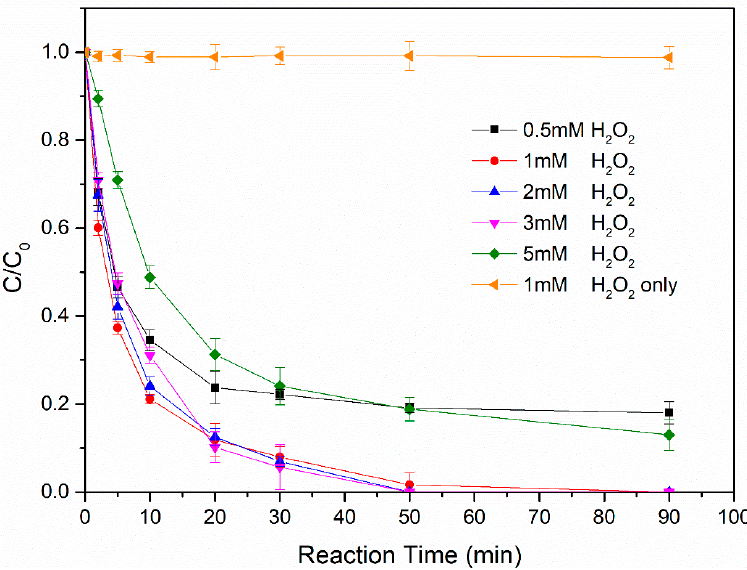
Figure 4. Effect of H 2 O 2 concentration on 2,4-D degradation ([2,4-D] 0 = 5.0 mg/L, [Fe 0 @Fe 3 O 4 ] 0 = 0.5 Figure 4. E ff ect of H 2 O 2 concentration on 2,4-D degradation ([2,4-D] 0 = 5.0 mg / L, [Fe 0 @Fe 3 O 4 ] 0 = 0.5 g / L, g/L, pH = 5.0 ± 0.2, T = 30 °C). pH = 5.0 ± 0.2, T = 30 ◦